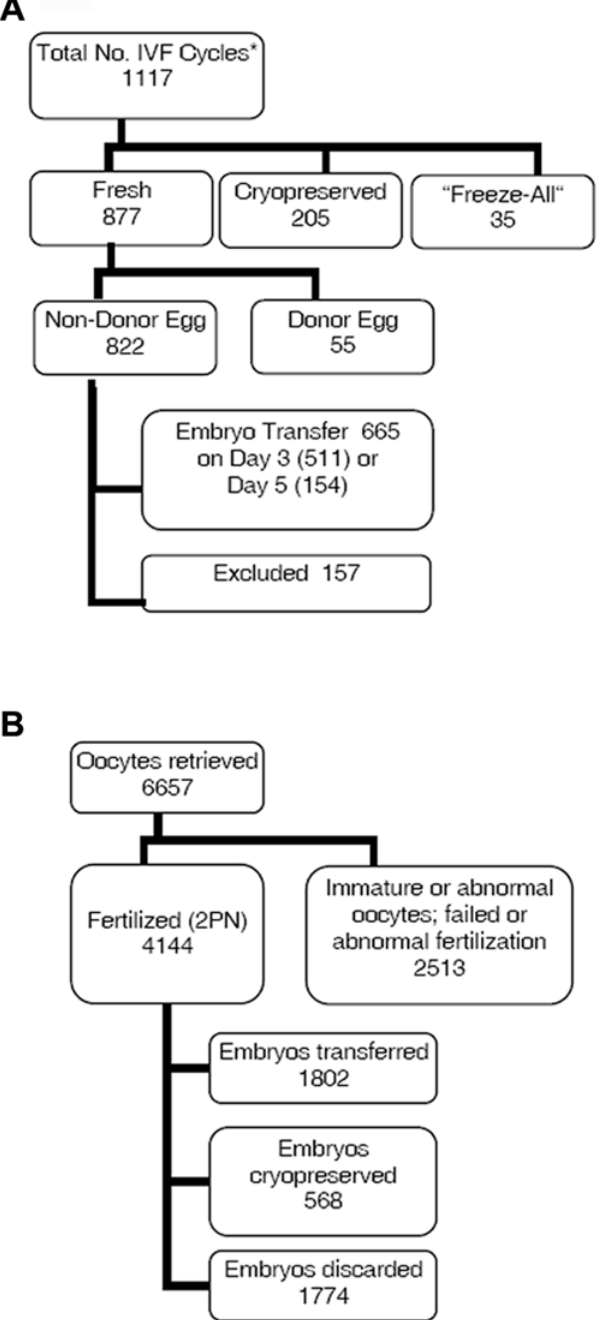
Figure 1. Source of data. A) IVF cycles performed in 2005. B) Utilization of oocytes and embryos in 665 fresh, non-donor IVF cycles. * All numbers in Panel A indicate the number of cycles and numbers in Panel B indicate the number of oocytes or embryos. Fresh cycles are defined by ovarian stimulation of gonadotropins and embryo transfer performed within the same cycle; cryopreserved cycles utilize embryos that were obtained and cryopreserved from a previous cycle; ‘‘freeze- all’’ are cycles in which ovarian stimulation was performed, but embryos were cryopreserved instead of being transferred back within the same cycle for medical or non-medical reasons. 157 cycles were removed from analysis for a variety of medical and non-medical reasons that did not result in fresh embryo transfer (see SI Text for